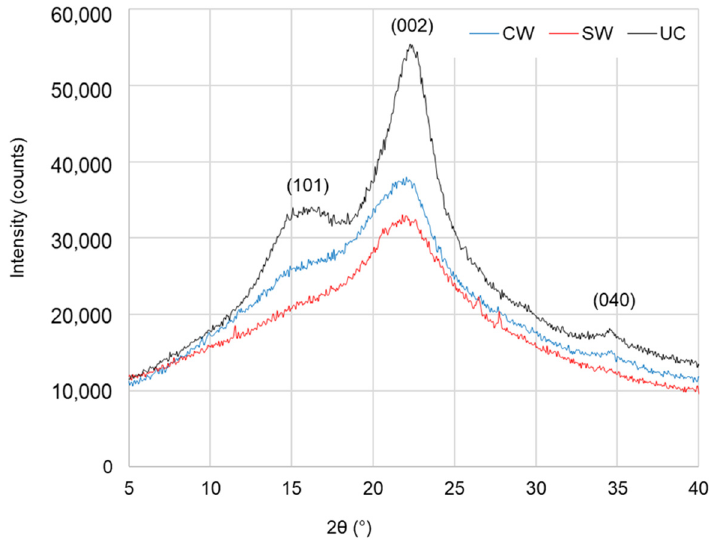
Figure 2. X-ray diffraction pattern of ancient shipwreck wood from Luoyang No.1 and undegraded contemporary wood.